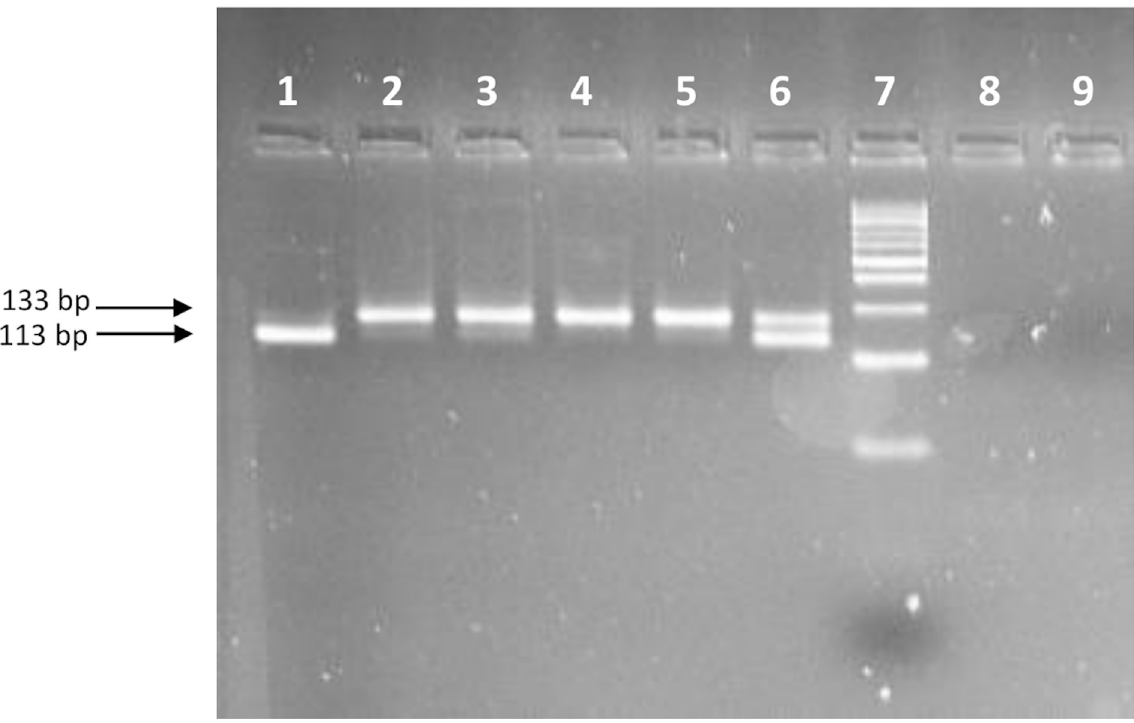
Fig 2. Agarose gel (4%) stained with GreenSafe Premium containing the amplified products of the AS-PCR assay to detect the V410L mutation. Lane 1: homozygous 410L genotype, lanes 2–5: homozygous 410V genotype, lane 6: heterozygous 410V/L genotype, lane 7: